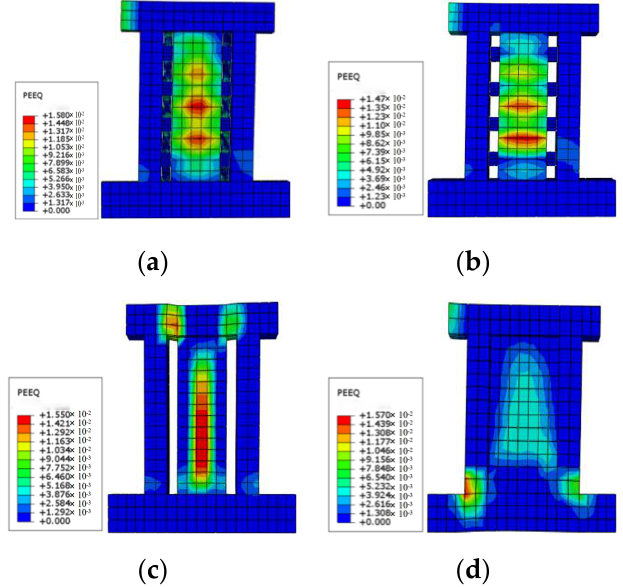
Figure 20. Concrete plastic strain cloud charts for each model. ( a ) Model ZP; ( b ) Model JJWK; ( c ) Model QZYK; ( d ) Model QZWK.